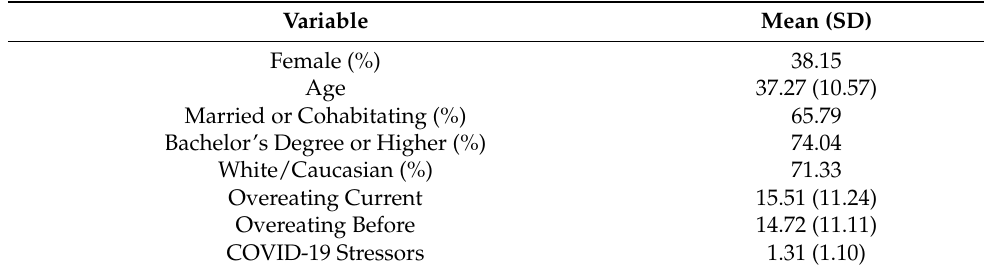
Table 1. Descriptive statistics, N =